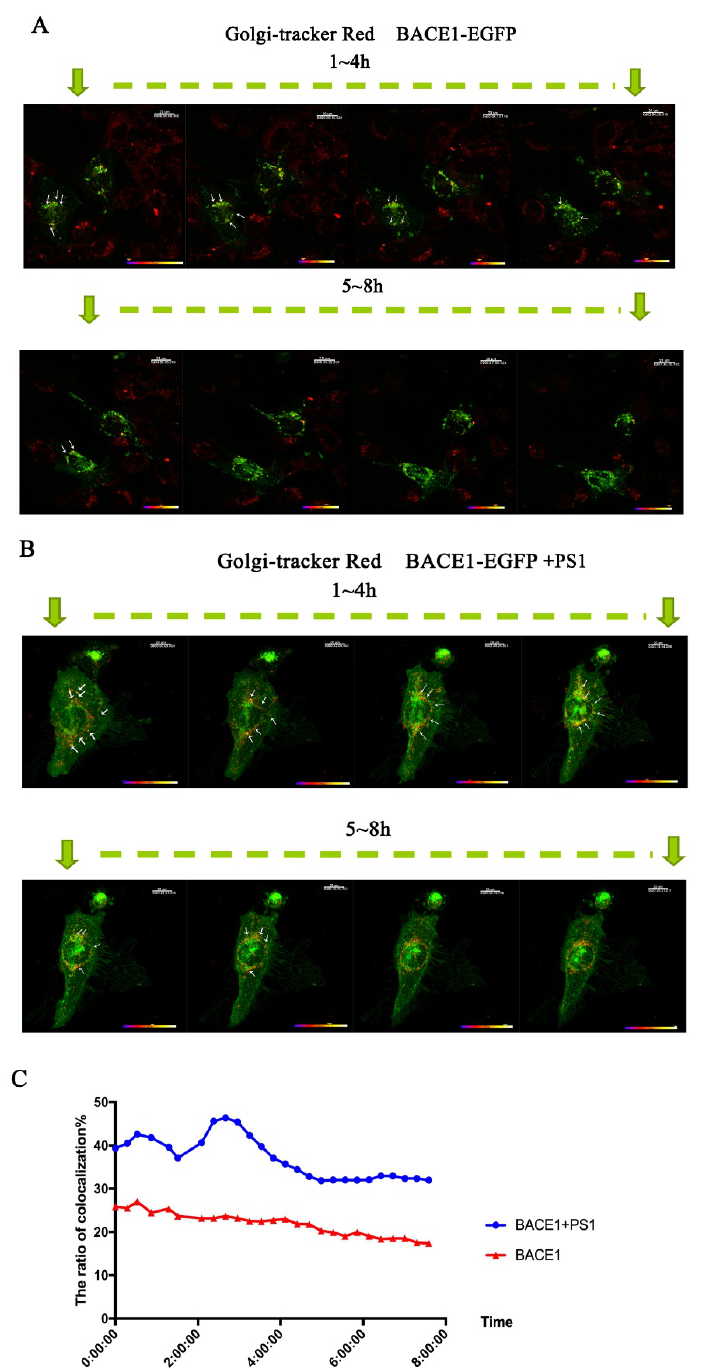
Figure 4. Time-lapse imaging of BACE1 and the Golgi tracker with or without PS1. ( A ) The distribution of BACE1-EGFP without PS1. ( B ) The distribution of BACE1-EGFP with PS1. ( C ) Quantitative analysis of the colocalization of BACE1 - EGFP and the Golgi tracker with and without PS1.